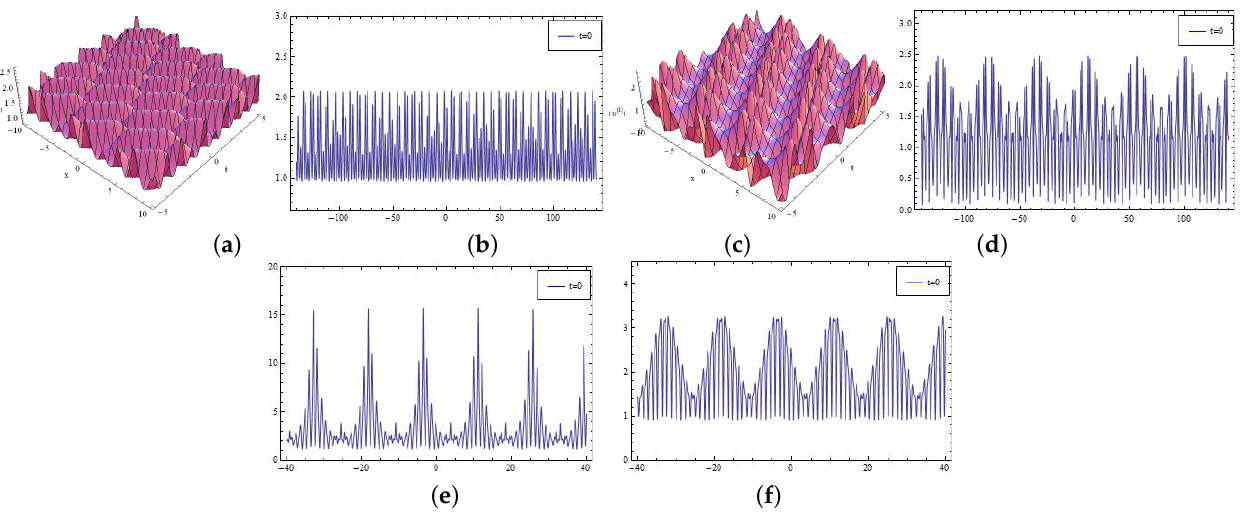
Figure 10. Breather-periodic wave solutions for Equation (5) with (cid:101) = 1, b = 1 with a = − 1, α 1 = 1 : ( a , b ) double-peak breather-periodic wave solution with d 12 = 1 + i 2 ( c , d ) double-peak breather-periodic wave solution with d 12 = i, d 13 = 1 + i with a = 1, α 1 = 3: ( e ) breather-periodic wave solution with d 12 = i, d 13 = 1 + i wave solution with d 12 = 1 + i , d 13 = 2